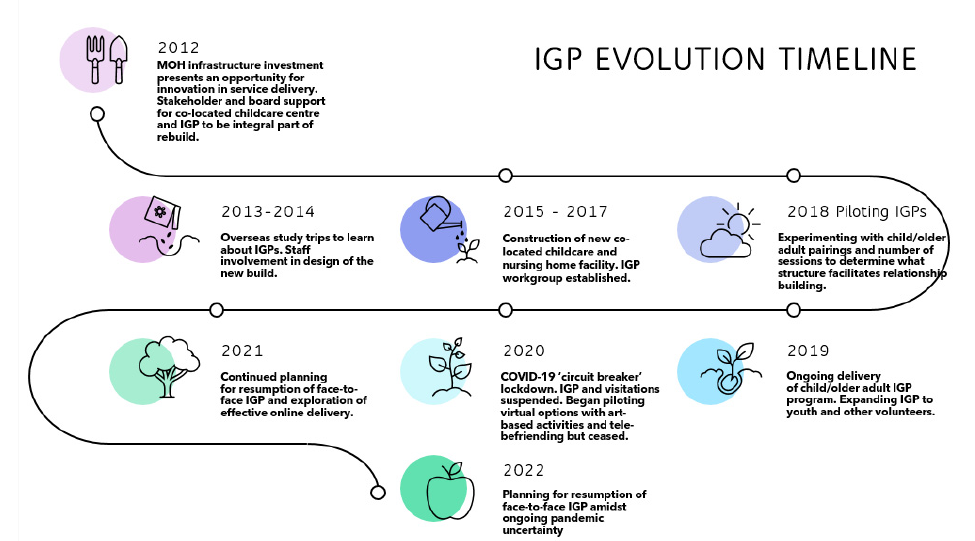
Figure 2. Timeline of the development of the intergenerational bonding program at St. Joseph’s Home, Singapore.